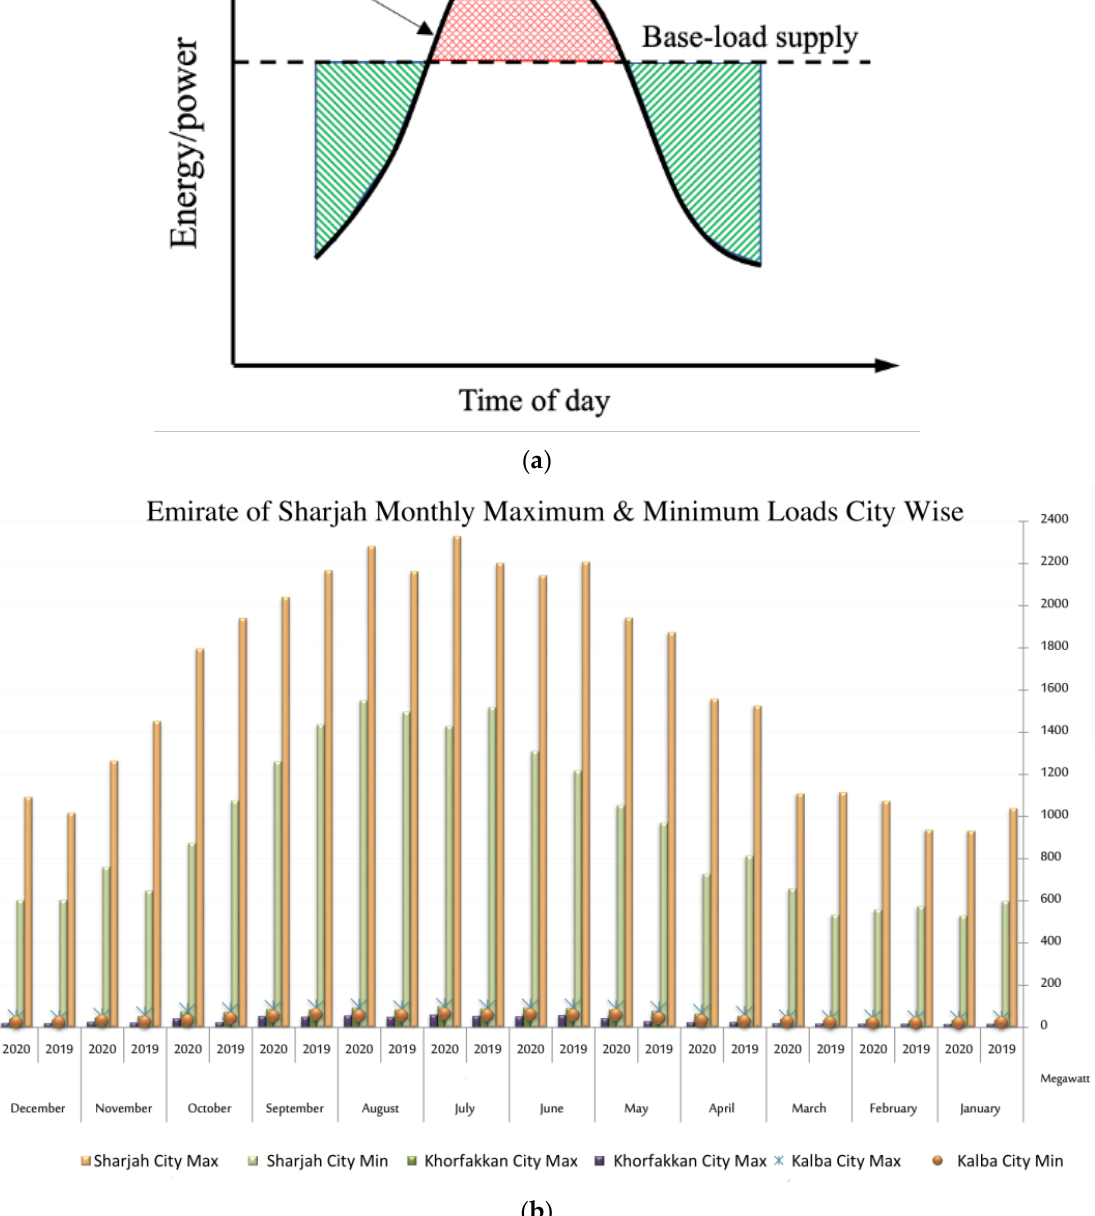
Figure 1. ( a ) A depiction of potential time for energy storage based on daily demand variation; green areas are where storage is permissible to keep powerplant operating at base load and ( b ) is actual demand for the Emirate of Sharjah, UAE, in 2020 compared to 2019.